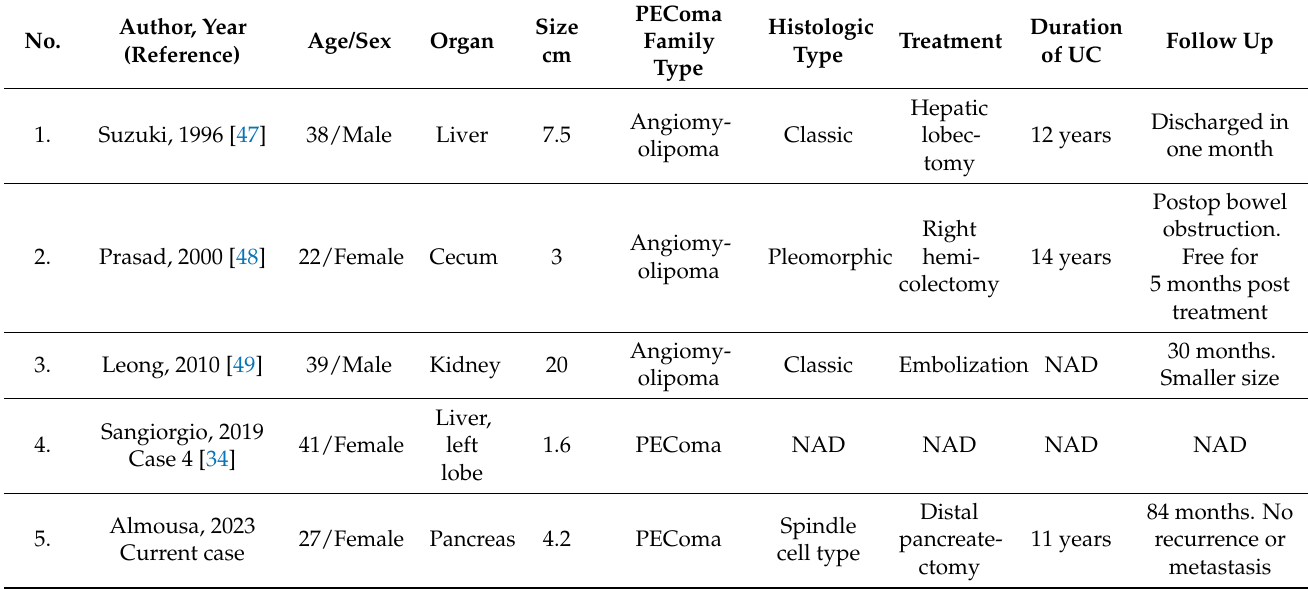
Table 2. Reported Cases of PEComa family in Patients with Ulcerative